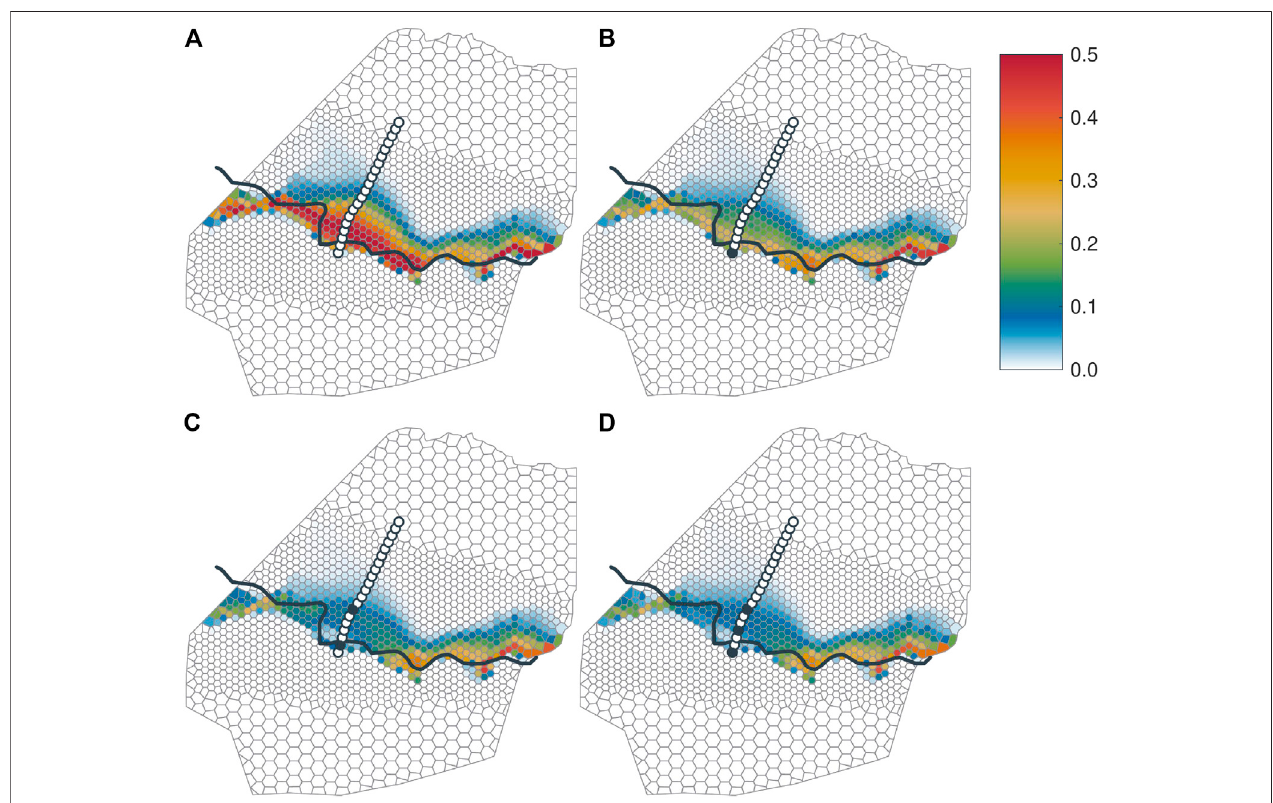
FIGURE 7 | Probability maps of misclassifying the attribution to the Ammer and Neckar subsurface-catchments P mc (cid:2) 2 P · ( 1 − P ) . (A) Prior P mc ; (B) : P mc for the best design with one additional piezometer; (C) : with two additional piezometers; (D) : with three additional piezometers.